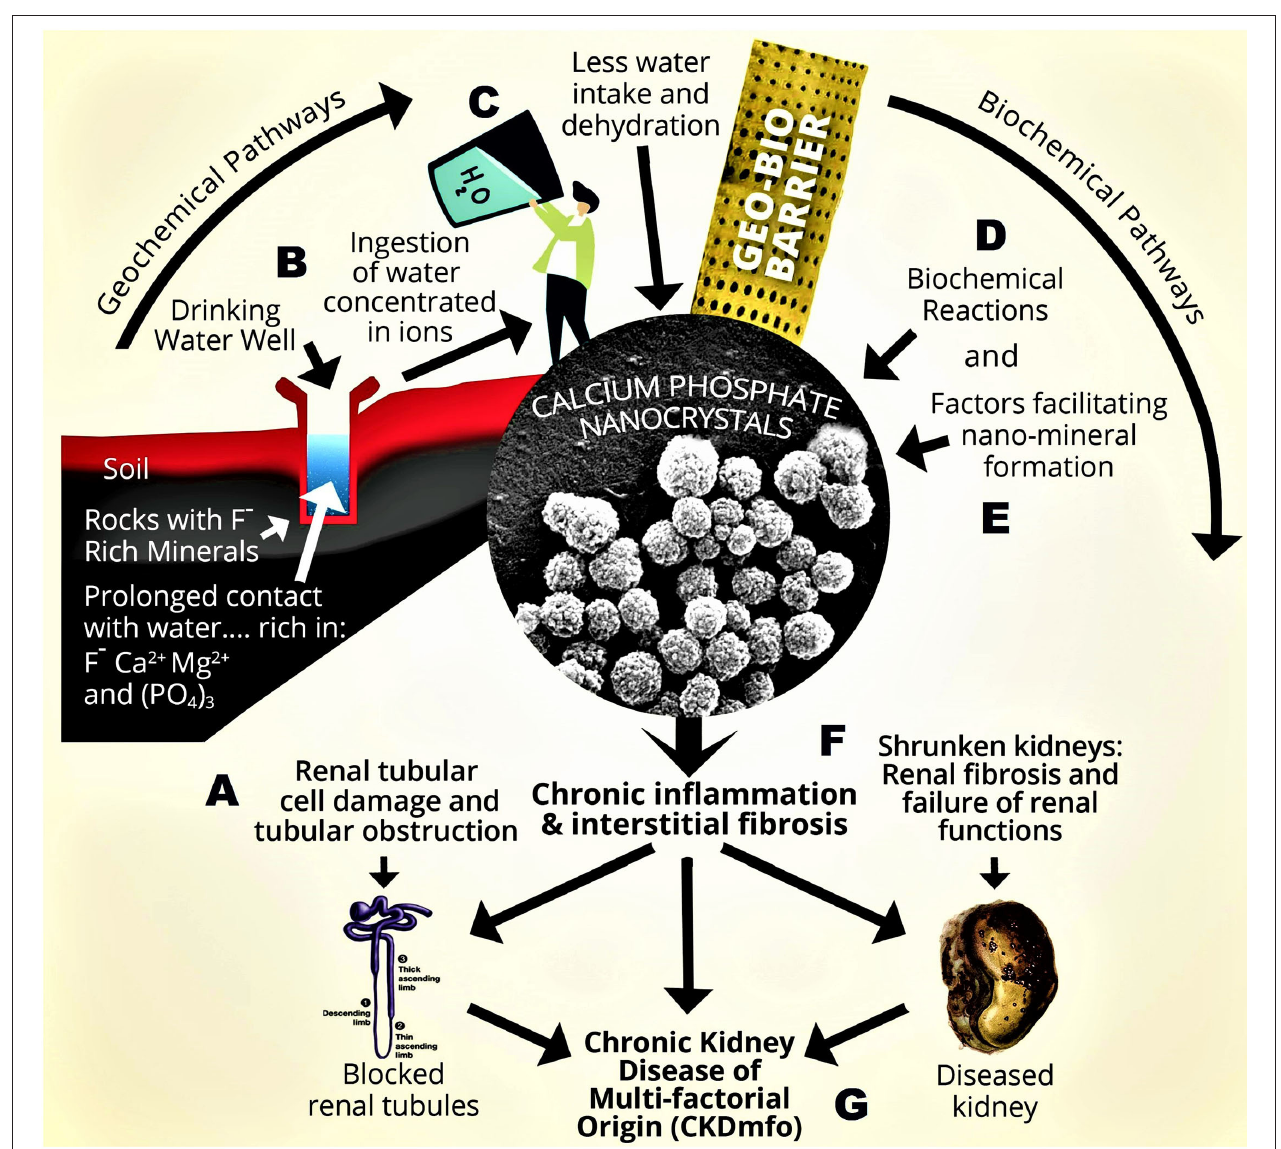
FIGURE 4 | Geological and biological (Geo-Bio) pathways for forming nano-tubes and nano-crystals in chronic kidney disease of CKD-CTN (CKDmfo). A conceptual diagram illustrating pathways for the formation of CaPO 4 nano-crystals in kidney tubules causing CKDmfo: (A) Stagnant groundwater is interacting with mineral-rich rocks, containing F − , Ca 2 + , Mg 2 + , and PO 3 − 4 . (B) Long duration of water–rock interaction. (C) Consumption of hard water (lesser amounts) with high concentrations of ions. (D) Biochemical reactions and supersaturation, precipitating CaPO 4 nano-crystals and nano-tubes in kidney tubules. (E) Factors enhancing the